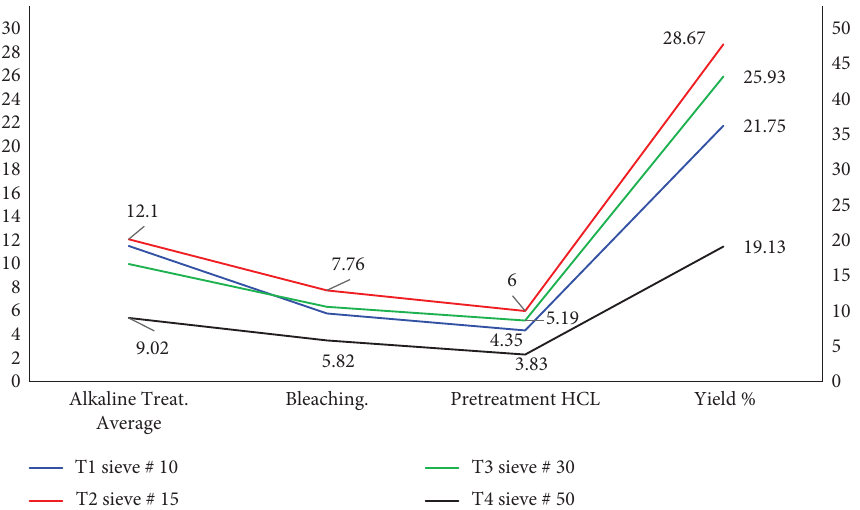
Figure 1: Averages obtained in cellulose yield with diferent sieves, cooking using alkaline treatment (NaOH) 5%, bleaching, and pre- treatment HCl. Treatments T1 (sieve # 10), T2 (sieve # 15), T3 (sieve # 30), and T4 (sieve # 50). (source: author himself).